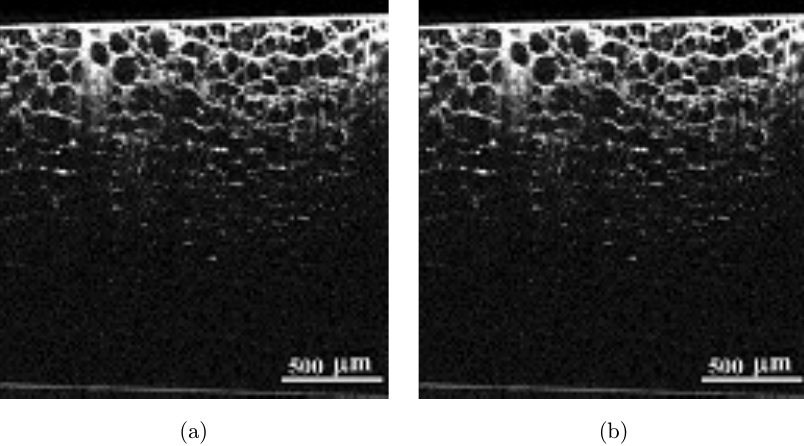
Fig. 3. OCT images of the ICG-stained fat tissue before irradiation (a) and during 5 min after irradiation (b). The light source was CW laser diode (VD-VII DPSS, 808 nm). The concentration of ICG was 1 mg/mL.